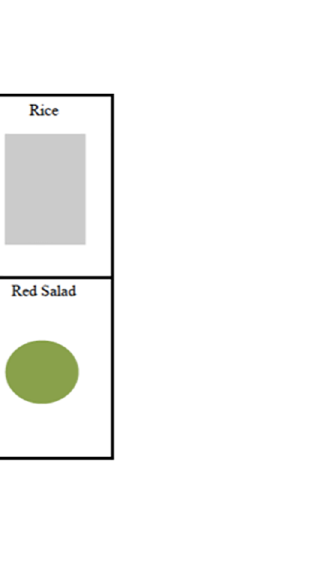
Fig 1. Visual presentation of the control